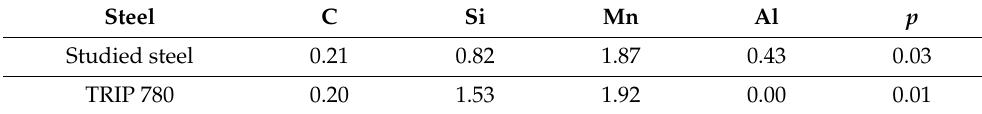
Table 1. Chemical compositions of the studied steel and TRIP 780 commercial steel (in wt%). Steel C Si Mn Al p Studied steel